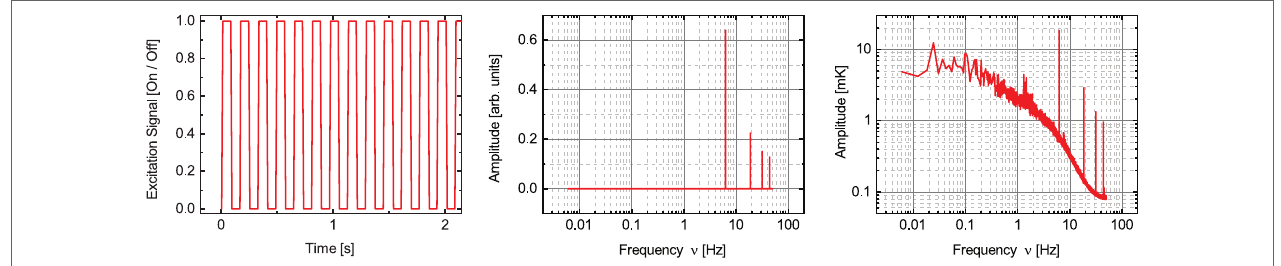
FigURe 8 | Example for excitation spectra of the amplitude damping method. The left figure shows the excitation signal, which is used to control the heat source. In the middle figure, the corresponding excitation spectrum is shown. The right figure shows the measured temperature spectrum of the water surface. The base frequency is 6.25 Hz. The third and fifth harmonic can clearly be seen.